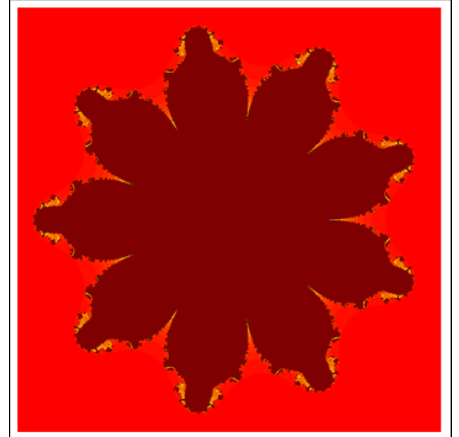
Figure 35. Decade Mandelbrot set.